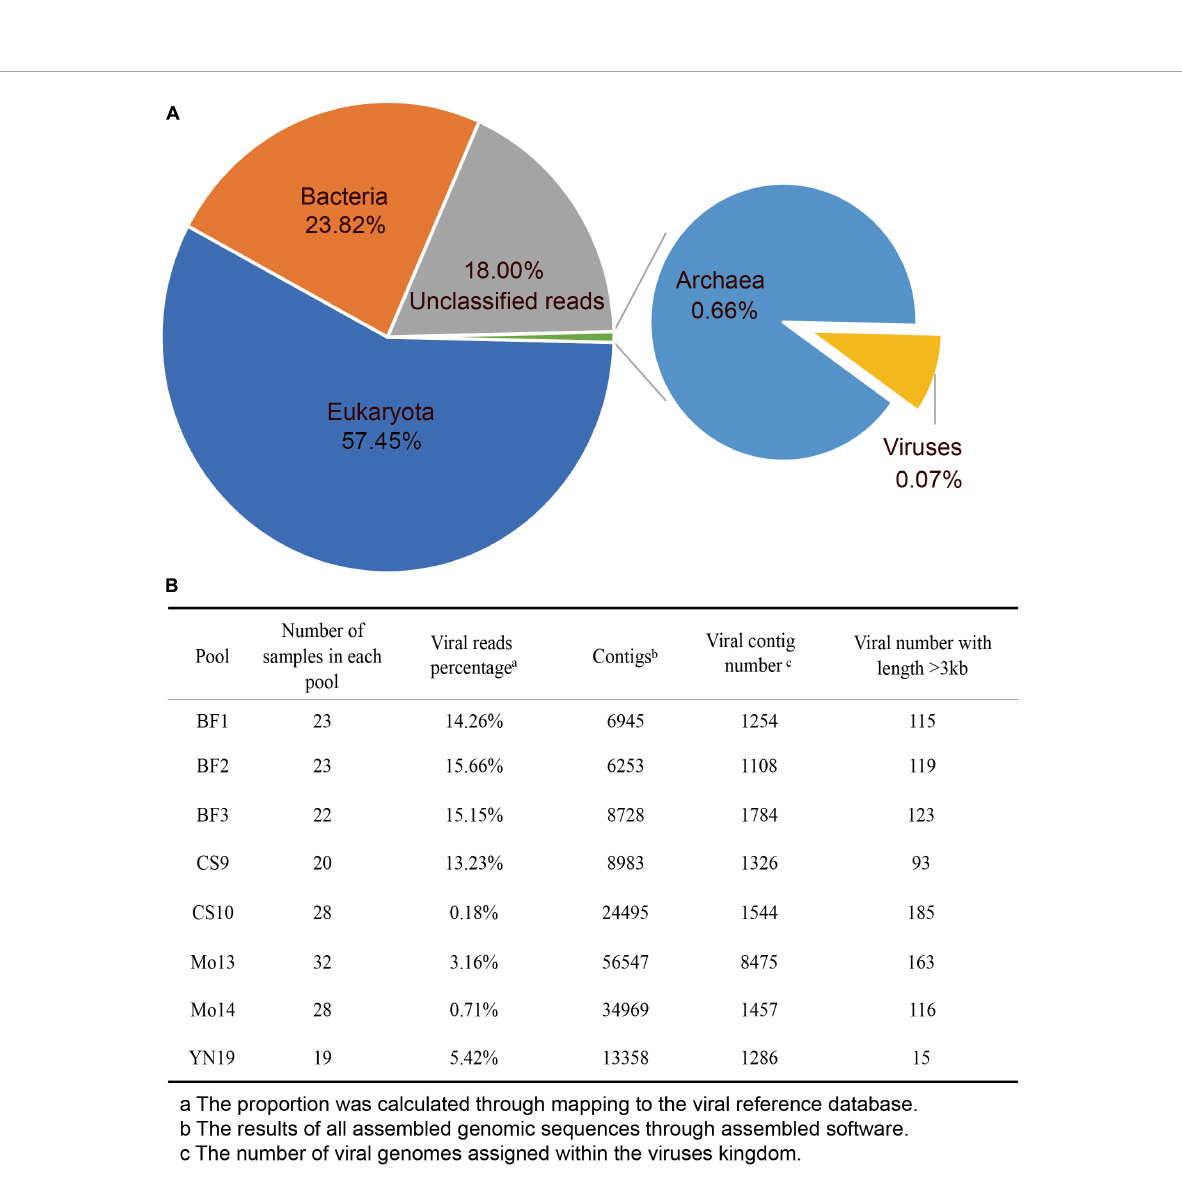
FIGURE1 Characteristics of virome data. (A) Pie chart of the viral species classifications based on the output data in the eight libraries. (B) The assembly statistics and viral taxonomic identifications in each